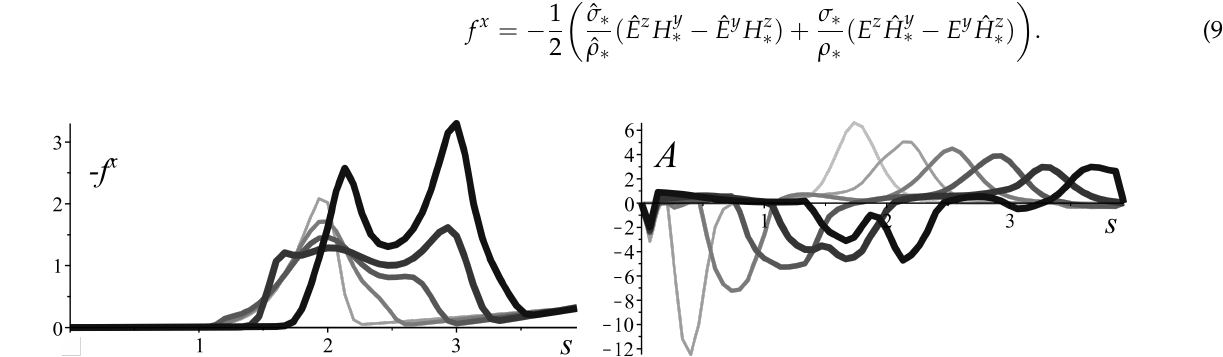
Figure 5. Evolution of the electromagnetic force − f x and the work on gas A for the first experiment.